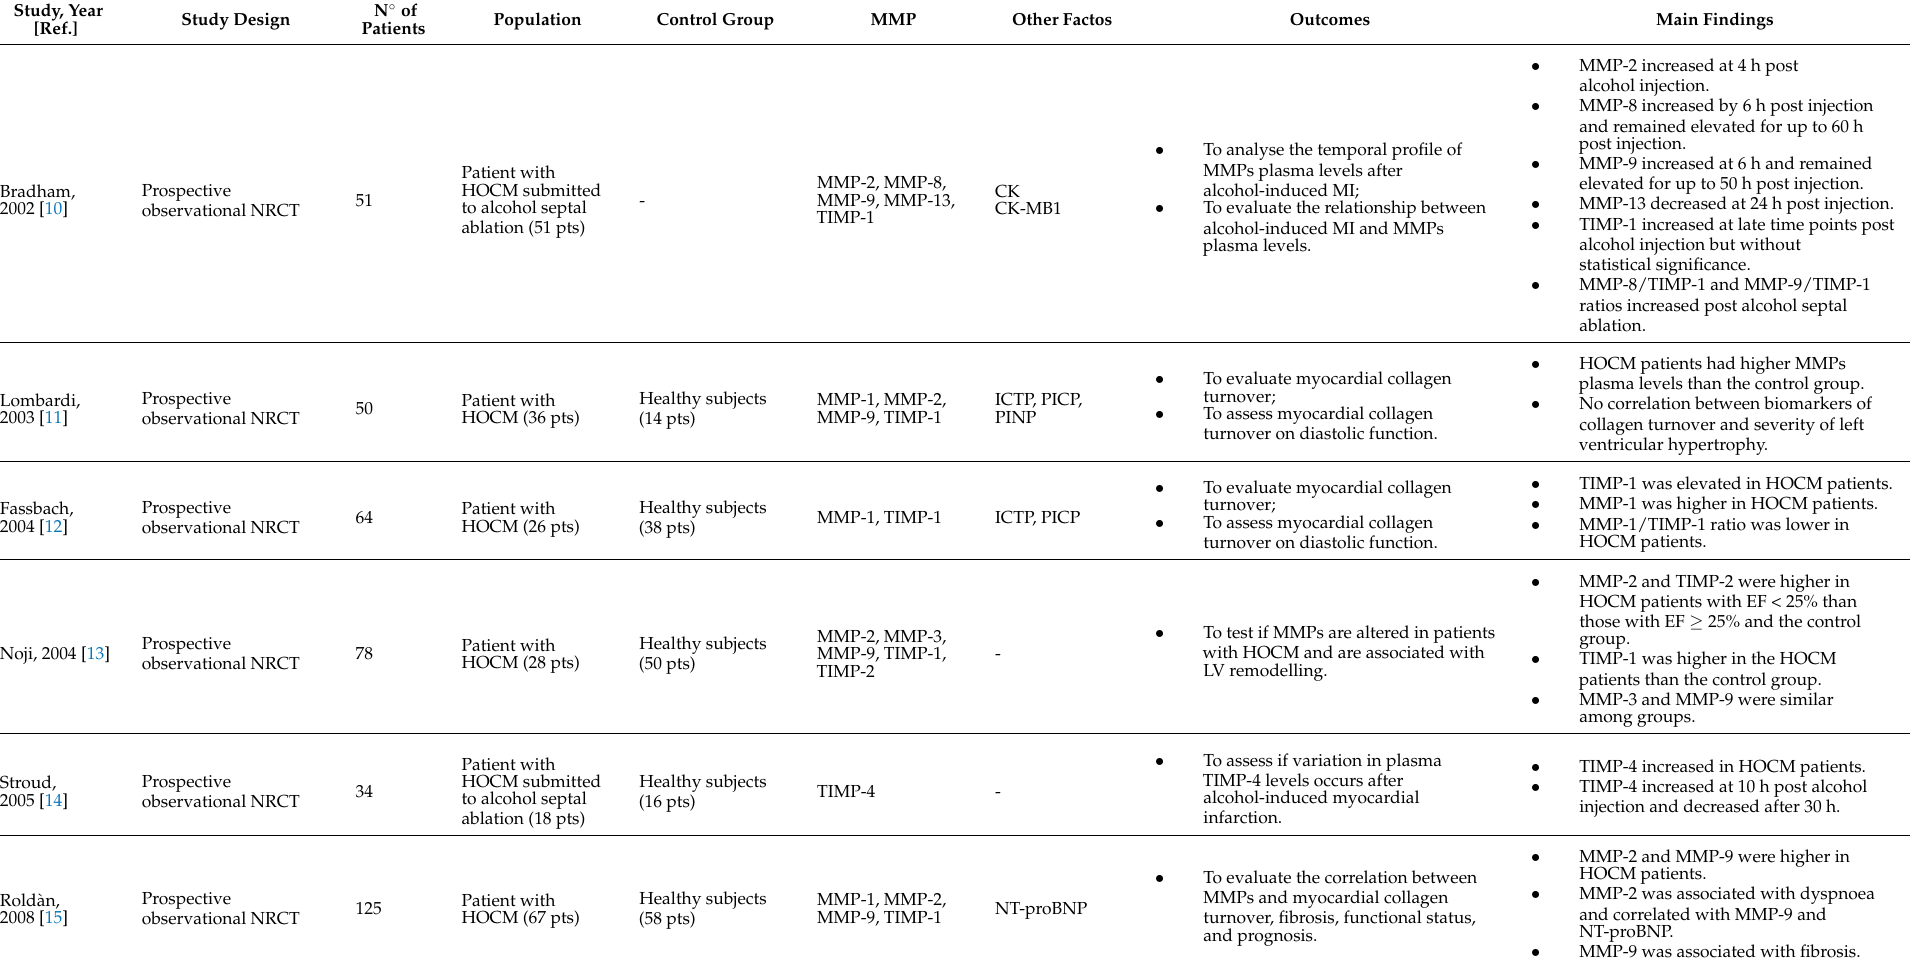
Table 1. Characteristics of the included